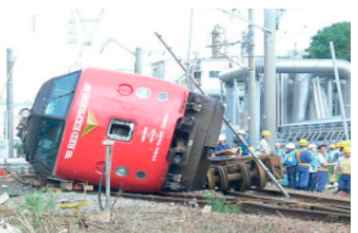
Figure 1. Derailment accidents in Japan by strong cross-winds. [4].